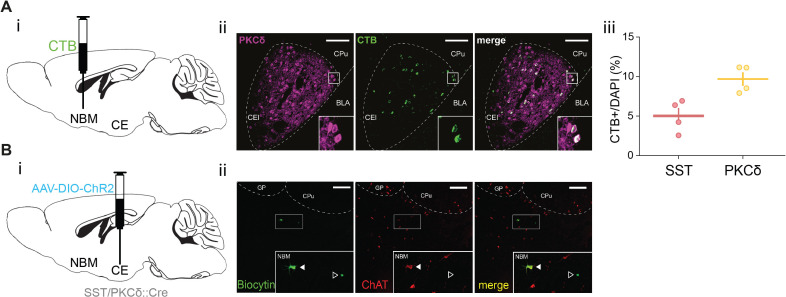
Anatomical and functional assessment of CE–NBM connectivity.(A) (i) Schematic of stereotactic injection of CTB into the NBM with (ii) exemplary backlabeling in CE (red) and PKCδ counterstain (magenta) and (iii) quantification according to identified CEl populations. Each data point represents a single animal. (B) (i) To assess synaptic connectivity between CEl subpopulations and NBM shown in Figure 4C, SST::Cre and PKCδ::Cre mice received injections of an AAV carrying Cre-dependent DIO-ChR2 in the CE. (ii) Representative slice showing biocytin-filled and fluorescently labelled streptavidin-stained patched neurons (green) and immunolabeled ChAT+ neurons (red) in NBM. Arrows indicate exemplary magnocellular (mc, filled) and parvocellular neurons (pv, hollow).